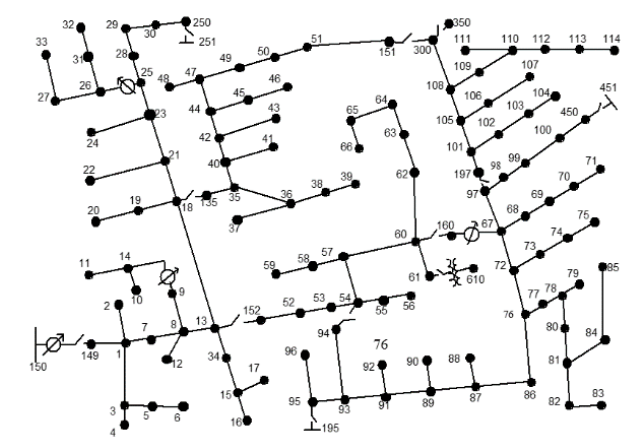
Figure 9. IEEE 123 bus electric test feeder single-line diagram.